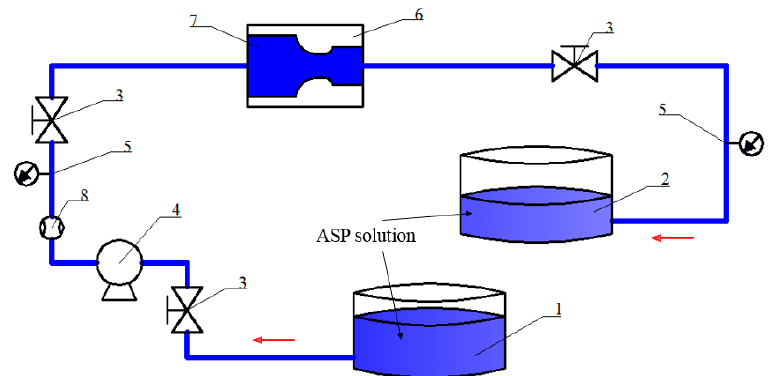
Figure 2. Technological process: (1) stirrable liquid supply tank; (2) return liquid tank; (3) valve; (4) screw pump; (5) pressure gauge; (6) flow simulation chamber; (7) different medium tool; (8) flow meter.